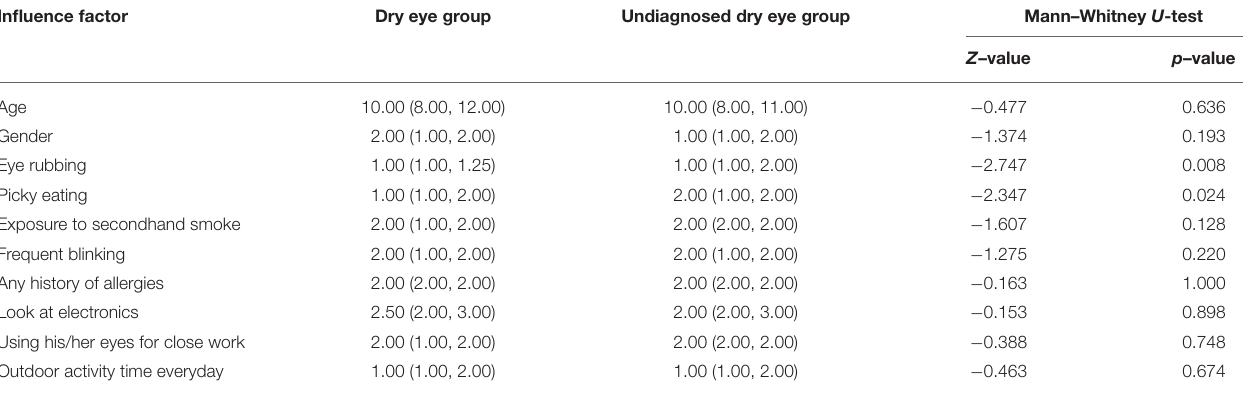
TABLE 3 | Influence of various factors on the prevalence of dry eye.